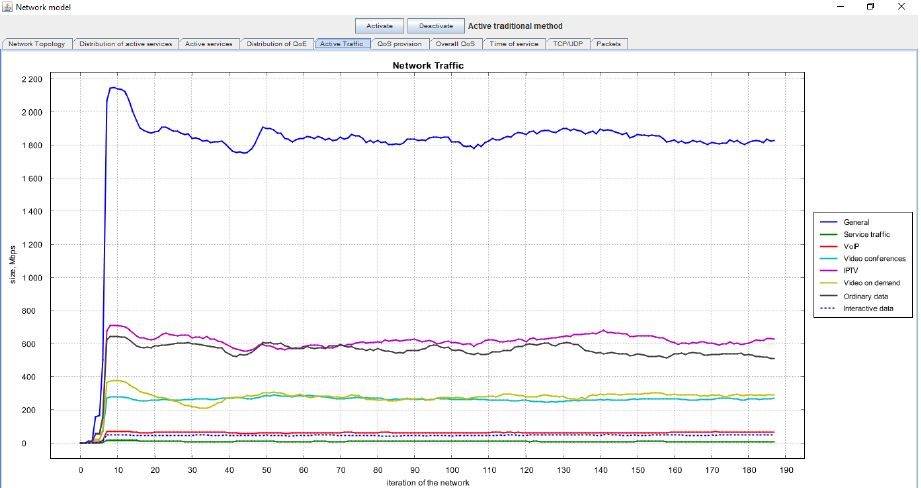
Figure 23. Network traffic.